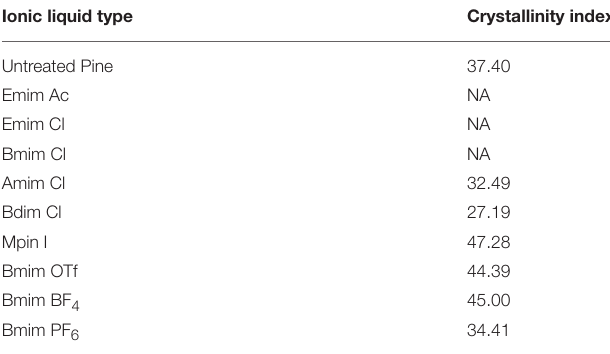
TABLE 2 | Crystallinity Index (CI) of pine treated with various ionic